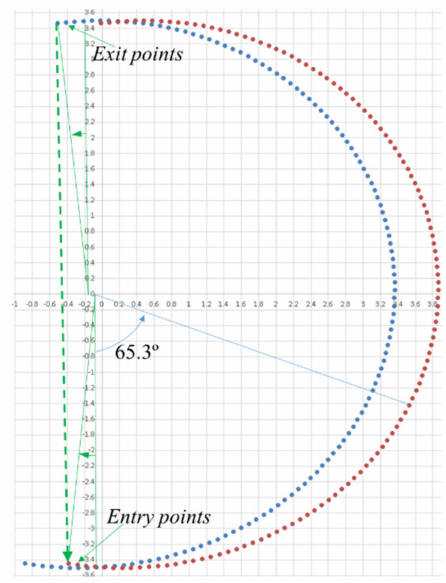
Figure 17. Extension of the entry and exit